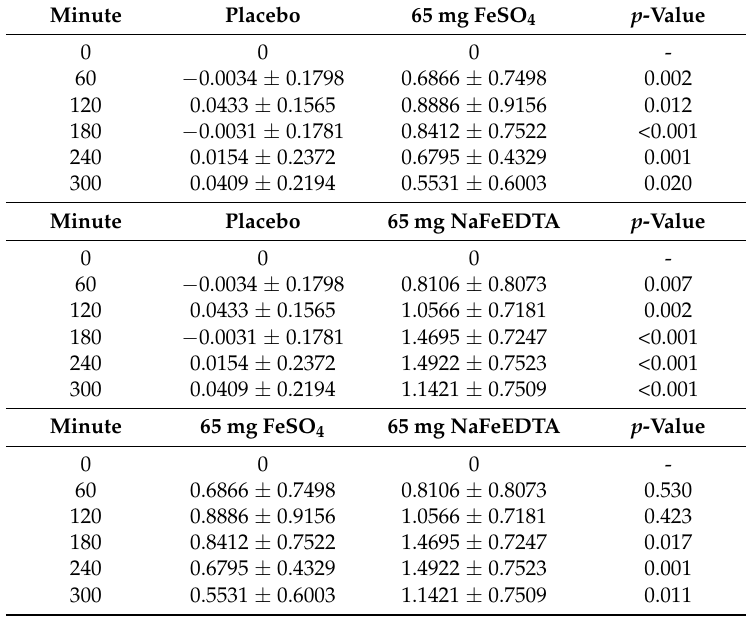
Table 2. NTBI ( µ mol/L) generation after ingestion of a meal, followed by 0 mg Fe (placebo), 65 mg FeSO 4 and 65 mg